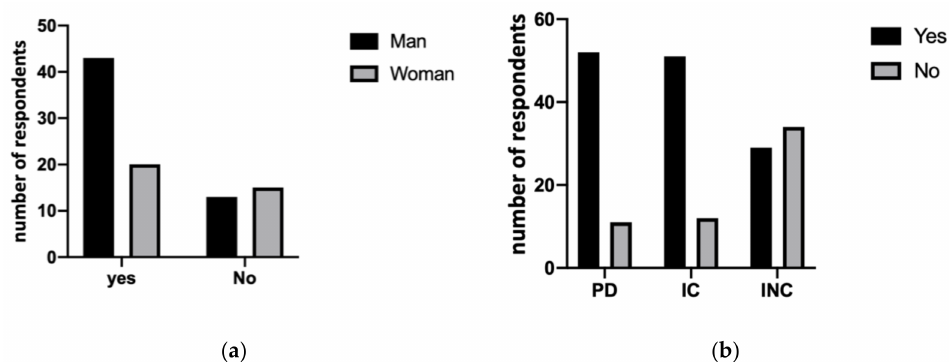
Figure 1. ( a ) Results of χ 2 test between males and females showed no statistically significant differ- ence in terms of treating (yes) or not treating (no) people with disabilities ( p = 0.0628). ( b ) Evaluation of differences between physical disability (PD), collaborating (IC) and non-collaborating (INC) intel- lectual disabilities between those who reported treating (yes) or not treating (no) patients ( p <